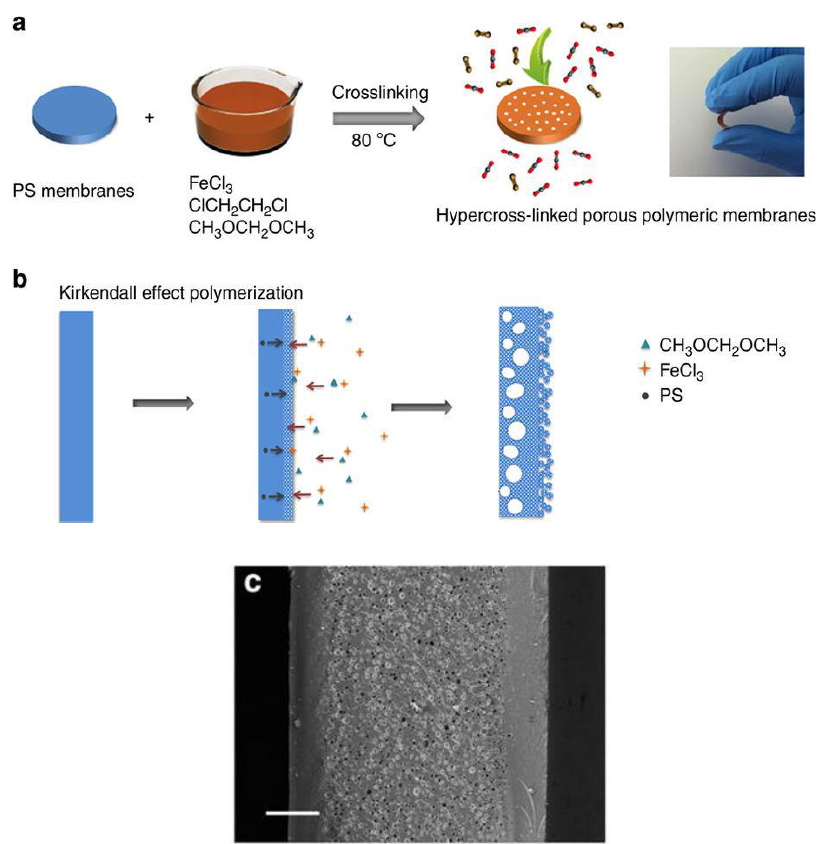
Figure 3. Synthesis of the hyper-crosslinked porous polymeric membranes. ( a ) Schematic illustration of the preparation procedure for the porous polymeric membranes; ( b ) the non-equilibrium diffusion at the interface (the reaction is only shown for one side of the membrane); and, ( c ) SEM images of the cross-section of the porous polymeric membranes crosslinked for 24 h (scale bar 20 μm). Reprinted by permission from Macmillan Publishers Ltd. (Basingstoke, UK): Nature Communications [57], copyright 2014.